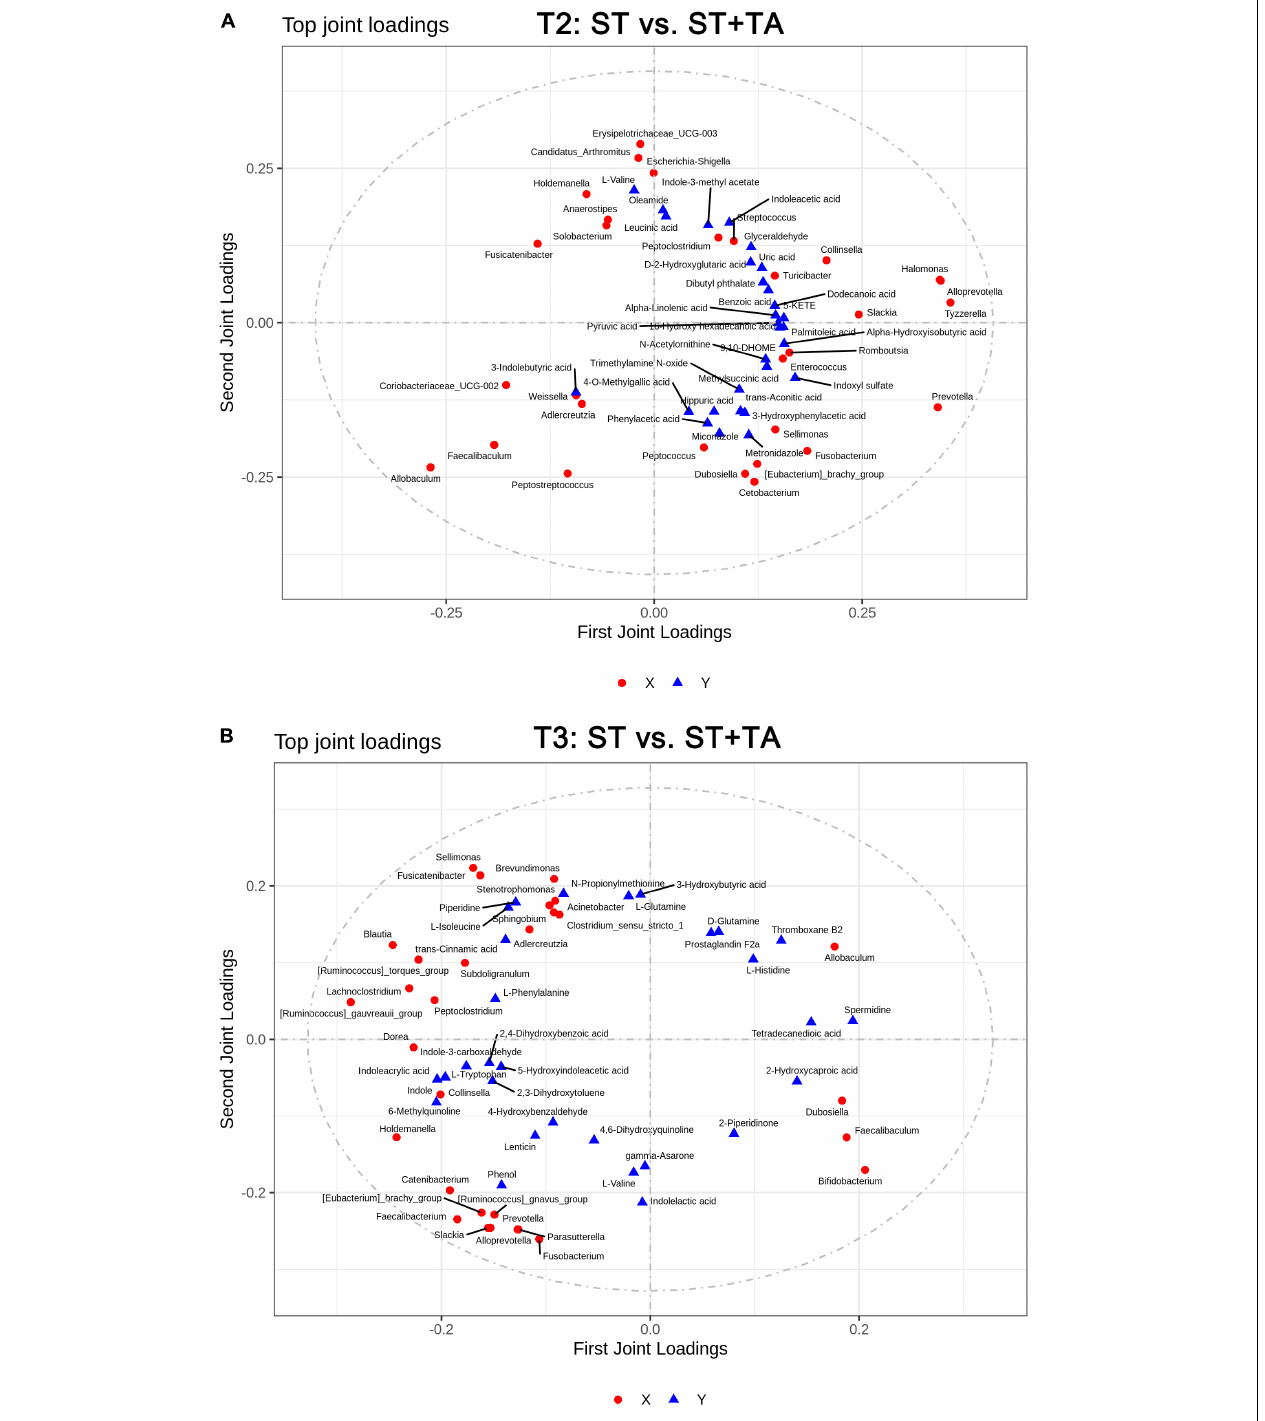
FIGURE 8 | Two-way orthogonal partial least squares (O2PLS) analysis of significant features identified from the microbiome and metabolomics analysis. Microbiome-metabolomics correlation loading plots between the ST and ST + TA groups at T2 (A) and T3 (B) . Red circle indicates bacteria at the genus level, and blue triangle indicates metabolite. The greater the absolute value in the coordinate, the greater the degree of association of this microbiota/metabolite with another omics. T2, day 8 after transportation; T3, day 14 after transportation.